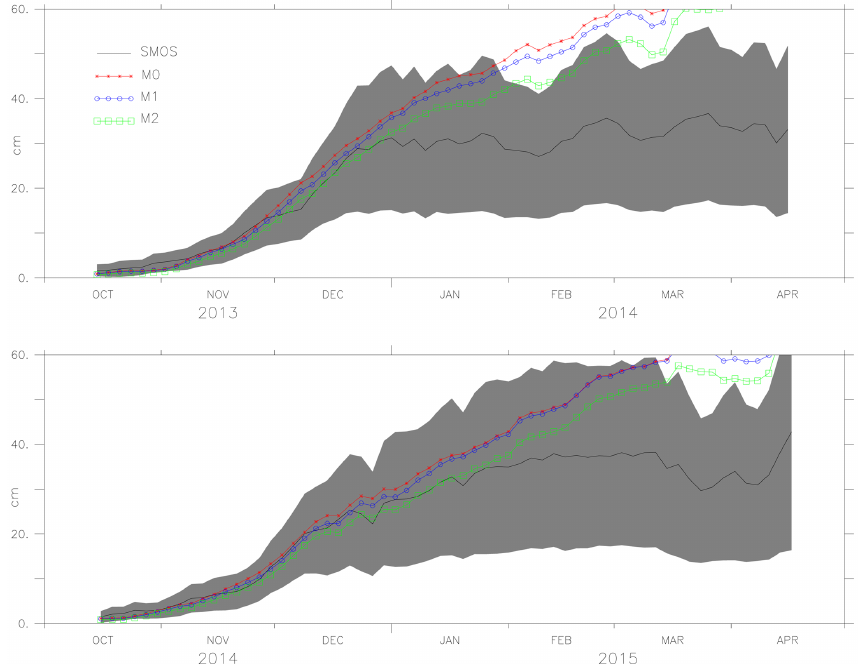
Figure 7. The ice thickness from the models M0, M1, M2 and observation (SMOS ice thickness) from October 2013 to April 2014 and October 2014 to April 2015. The uncertainty in the observation (SMOS ice thickness) is shaded in